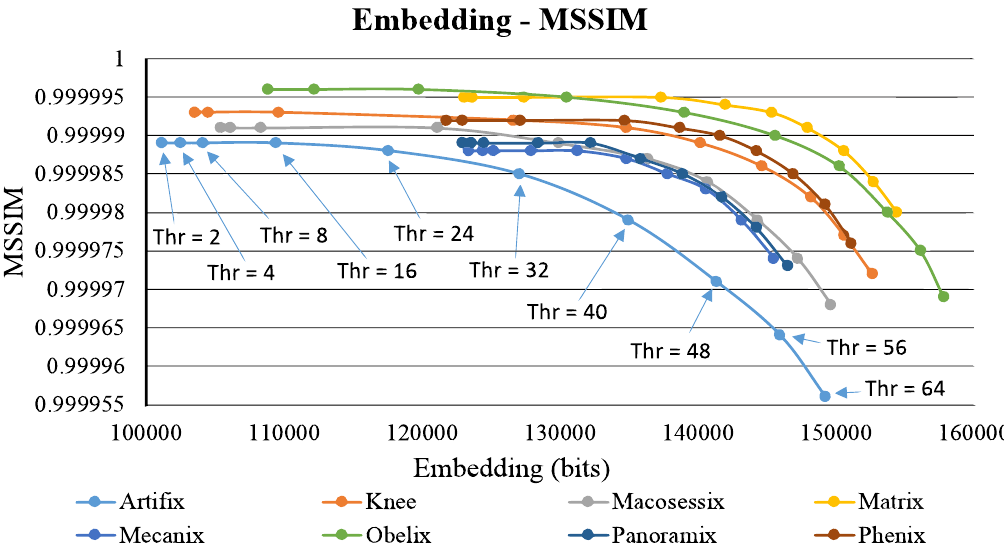
Figure 10. Results of self-evaluation using different threshold values in terms of embedding capacity versus Mean Structural Similarly Index Measure (MSSIM).